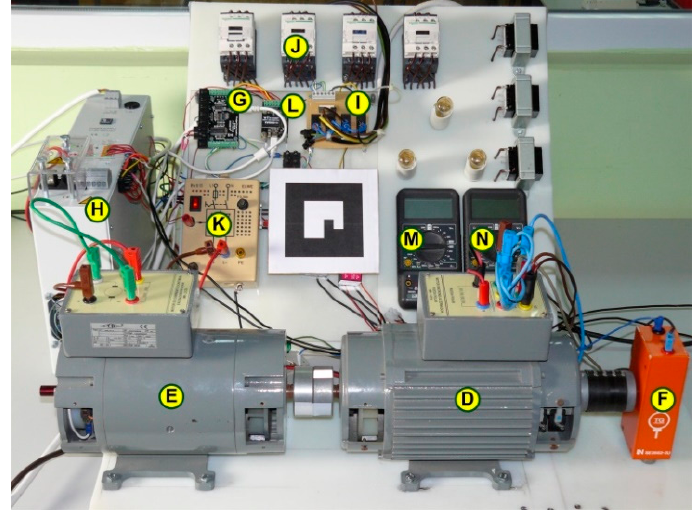
Figure 12. A plant to test commercial electric machines remotely.